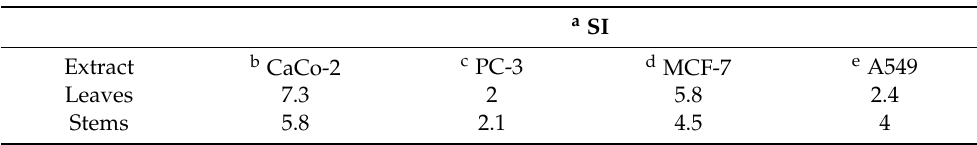
Table 2. Cytotoxic effects of methanol extract from R. mucronata against cancer cell lines. a IC 50 ( µ g/mL) Doxorubicin Cell Lines R. mucronata Leaves R. mucronata Stems (Positive Control) b CaCo-2 127 ± 4 *** 107 ± 6 ** 83 ± 1 c PC-3 480 ± 14 *** 294 ± 3 *** 79 ± 4 d MCF-7 158 ± 10 *** 138 ± 3 *** 80 ± 3 e A549 376 ± 9 *** 155 ± 10 *** 932 ± 30 *** 629 ± 3 *** 50 ± 5